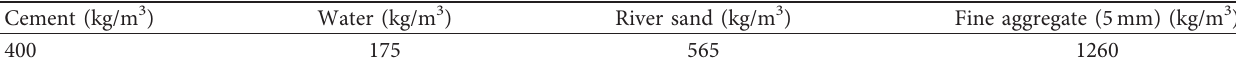
Figure 3: Dimensions of COF test specimen. (a) Floor plan of specimen. (b) A-A section. (c) Details of joint. Table 1: Mix proportion of concrete.